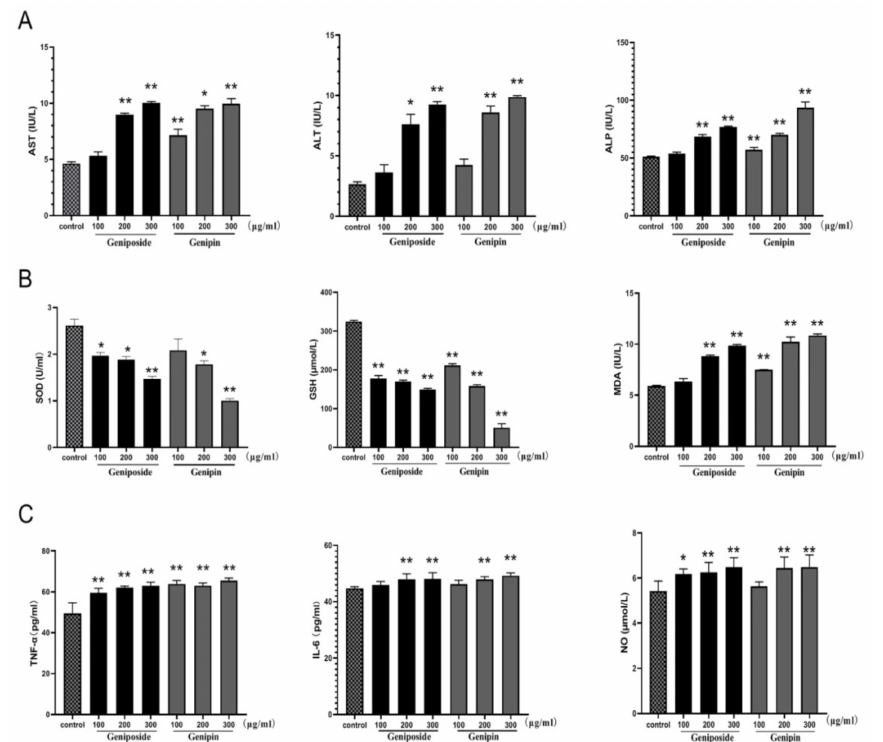
Figure 7. E ff ects of geniposide and genipin on ( A ) AST, ALT, and ALP; ( B ) SOD, GSH, and MDA; ( C ) TNF- α , IL-6, and NO. BRL3A cells were exposed to geniposide or genipin at 100, 200, and 300 µ g / mL concentrations. Values are expressed as mean ± SD ( n = 6), * p < 0.05; ** p < 0.01 vs. control